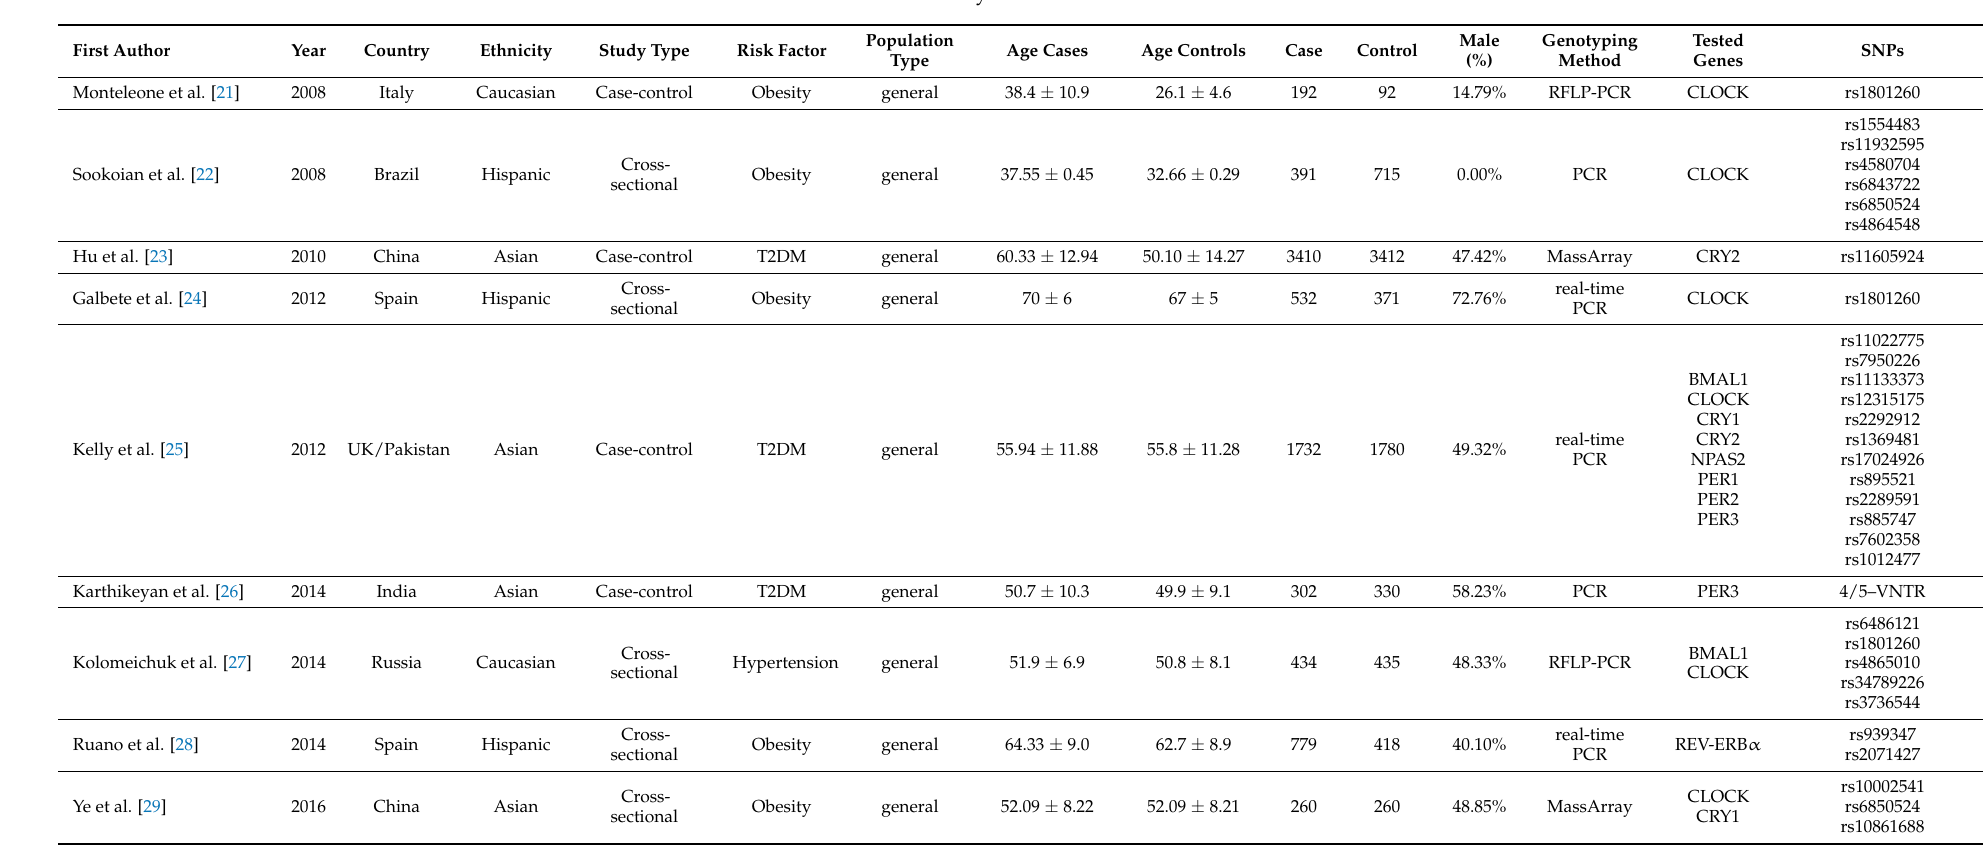
Table 1. Characteristics of studies included in the